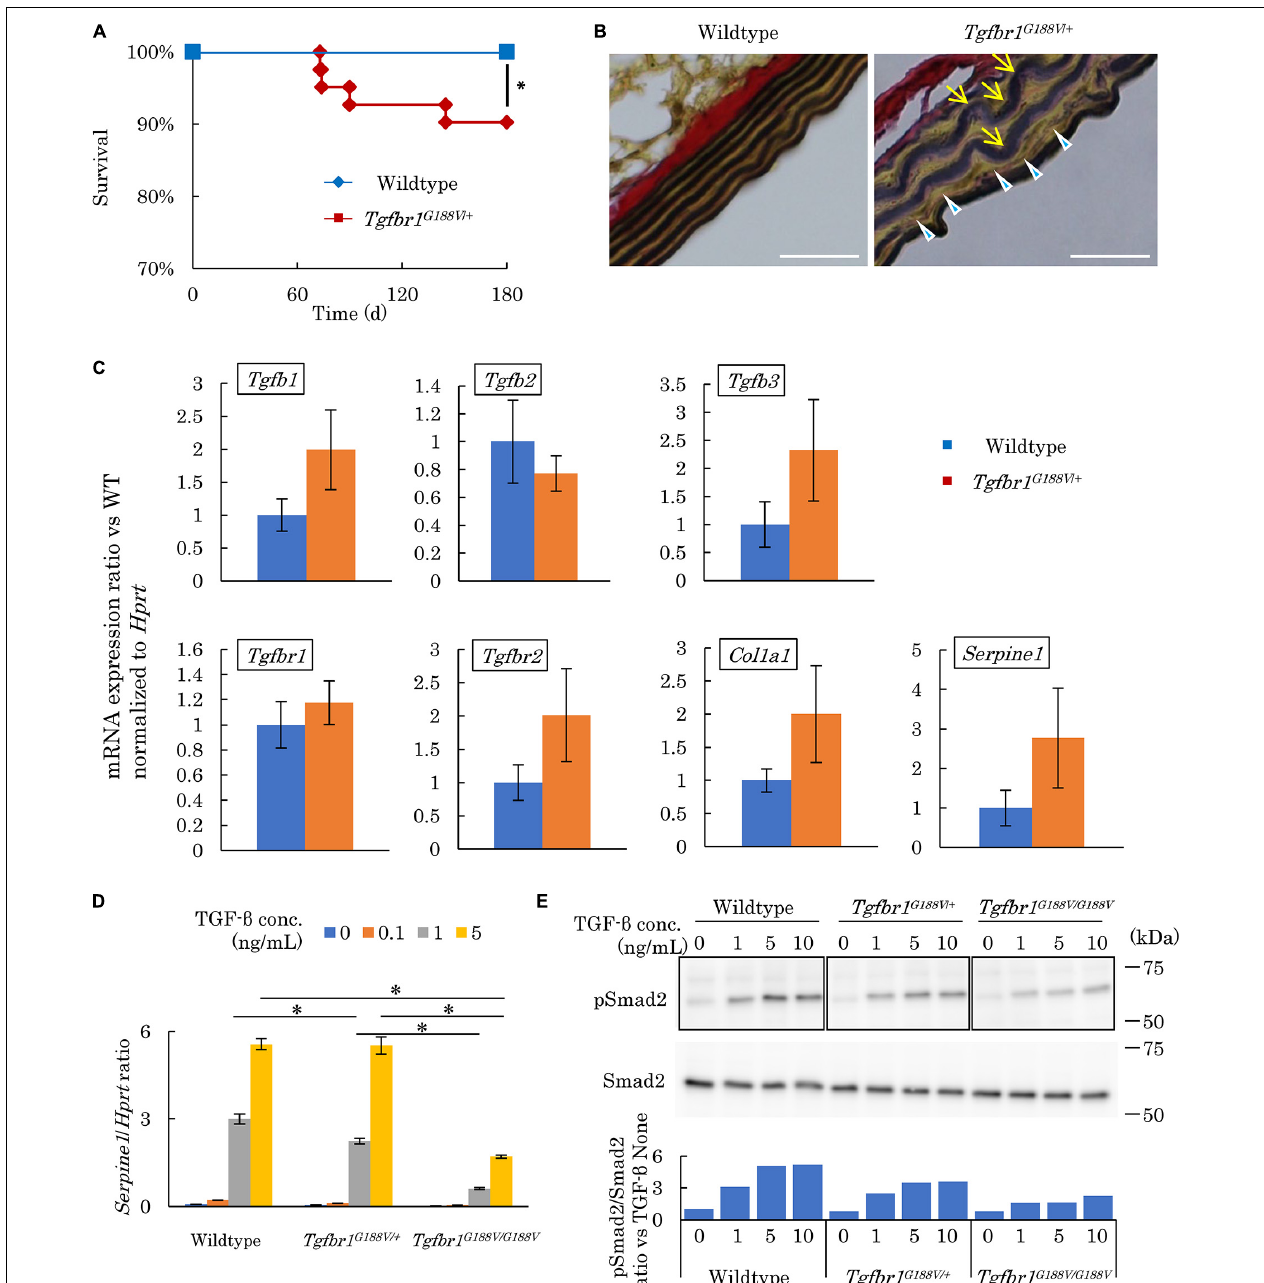
FIGURE 4 | Tgfbr1 G 188 V / + mice recapitulate vascular LDS phenotypes. (A) Kaplan–Meier survival curve showing a diminishing lifespan of Tgfbr1 G 188 V / + mice. ∗ P < 0.05. (B) Representative aortic wall sections of Tgfbr1 G 188 V / + mice at 24 weeks of age stained with EVG to identify elastin fibers. Scale bar: 25 µ m. Arrows show elastic fiber distortion. Arrowheads show elastic fiber fragmentation. (C) Analysis of TGF- β -related genes in aortic tissues derived from wildtype and Tgfbr1 G 188 V / + mice ( n = 4). Data represent means ± SD in triplicate assays. (D) Serpine1 gene expression in MEFs derived from wildtype, Tgfbr1 G 188 V / + , and Tgfbr1 G 188 V / G 188 V embryos at embryonic day 13.5 stimulated with TGF- β (0–5 ng/mL). Data represent means ± SD in triplicate assays. ∗ P < 0.05, compared with the indicated TGF- β concentration. (E) Phospho-Smad2 (pSmad2) in MEFs derived from wildtype, Tgfbr1 G 188 V / + , and Tgfbr1 G 188 V / G 188 V embryos at embryonic day 13.5 stimulated with TGF- β (0–10 ng/mL). Quantitative western blot analysis is shown as the ratios of the intensities of phospho-Smad2 to Smad2.